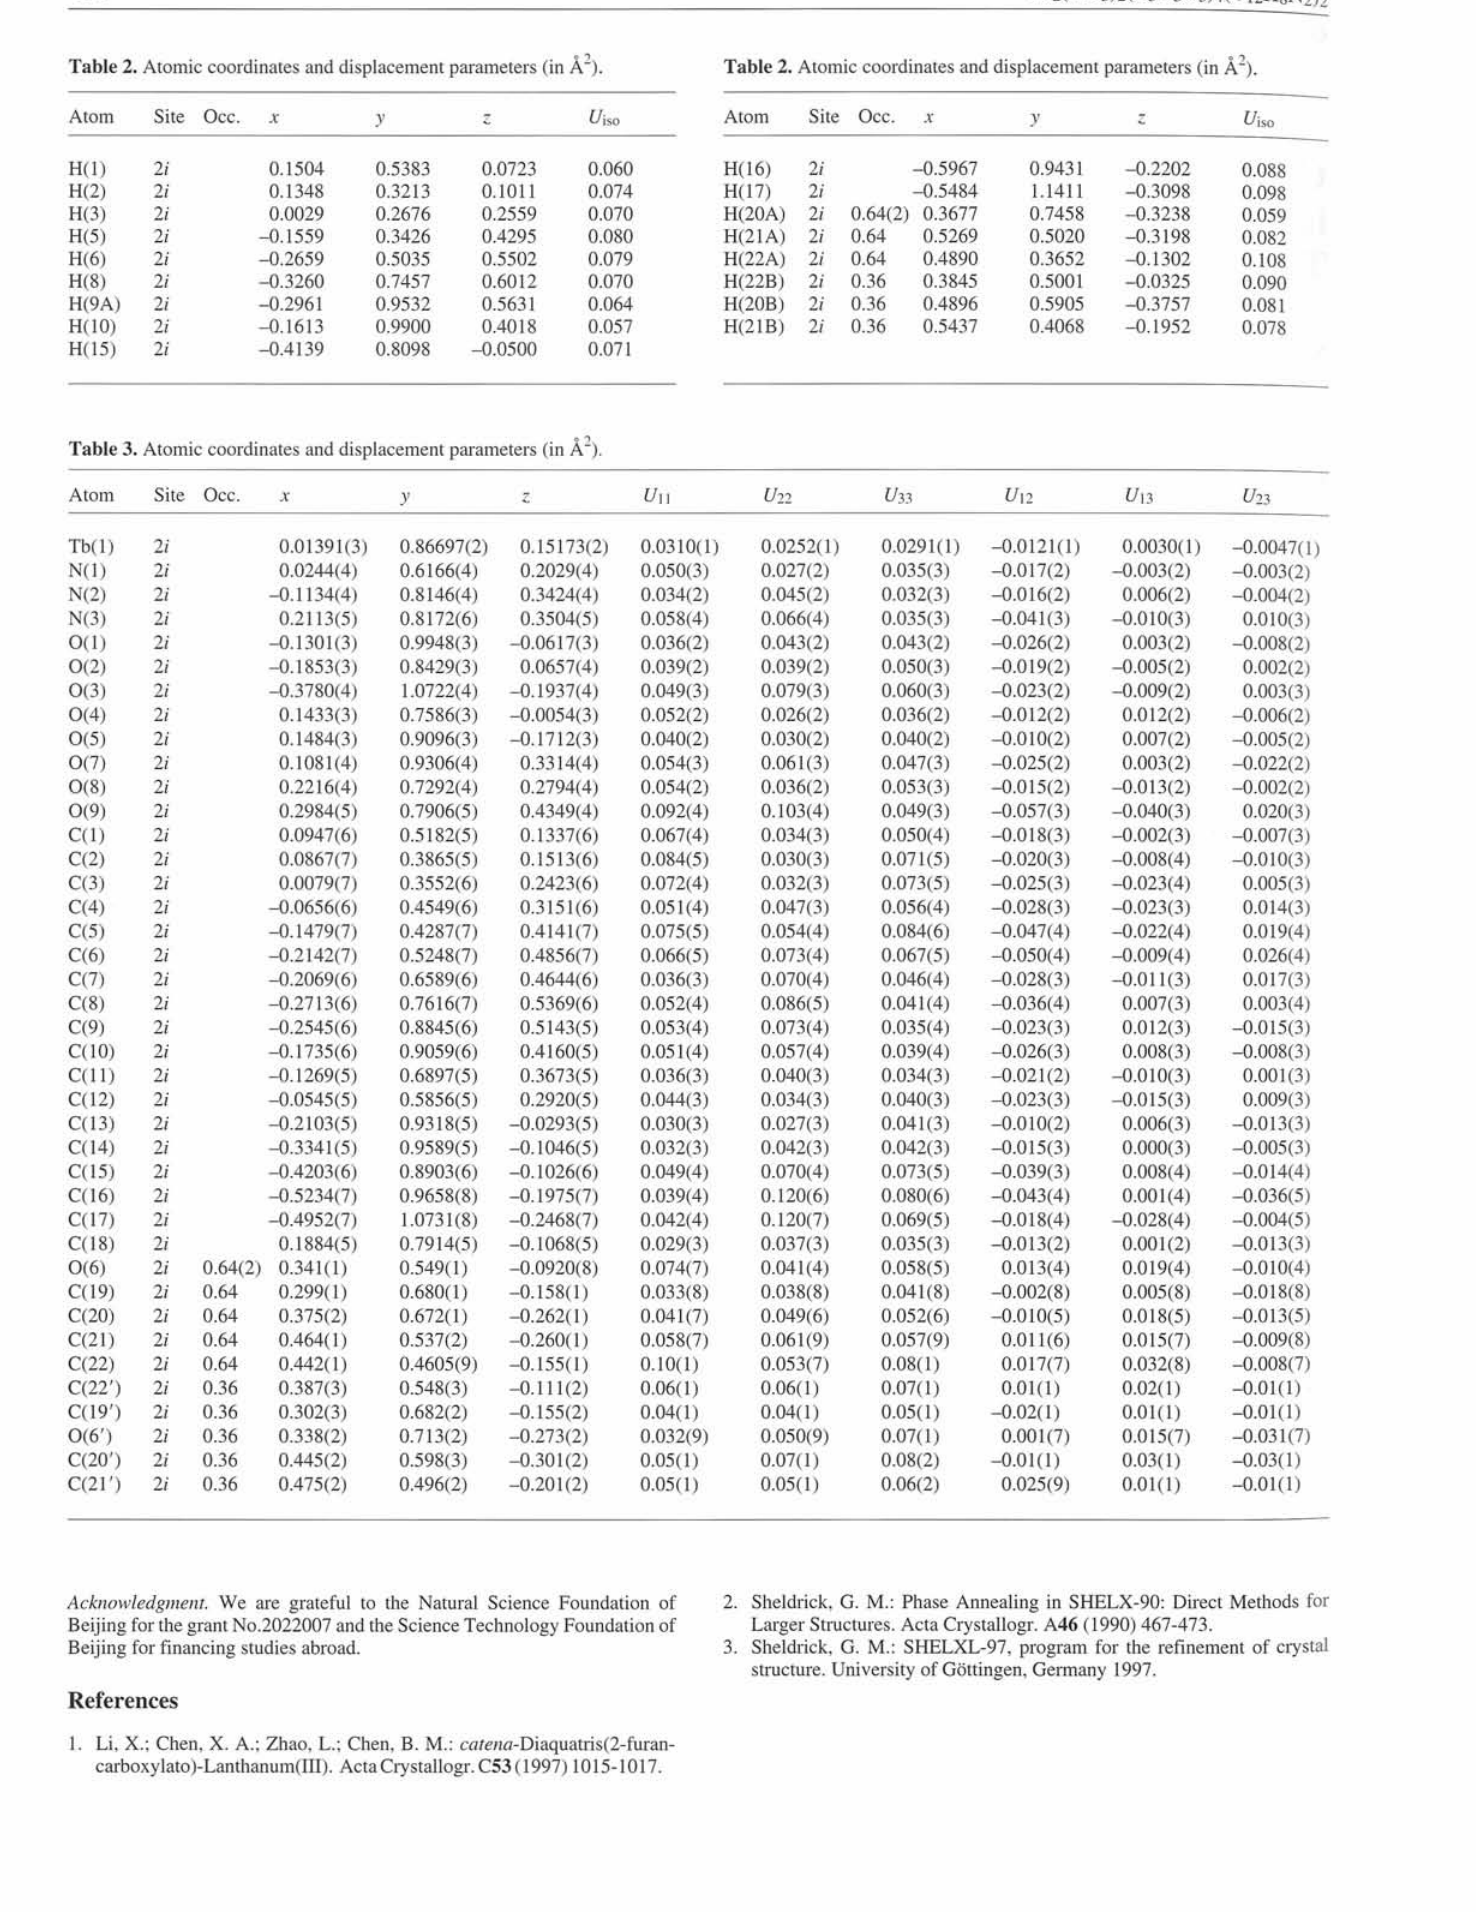
Table 2. Atomic coordinates and displacement parameters (in Â 2 ). Atom